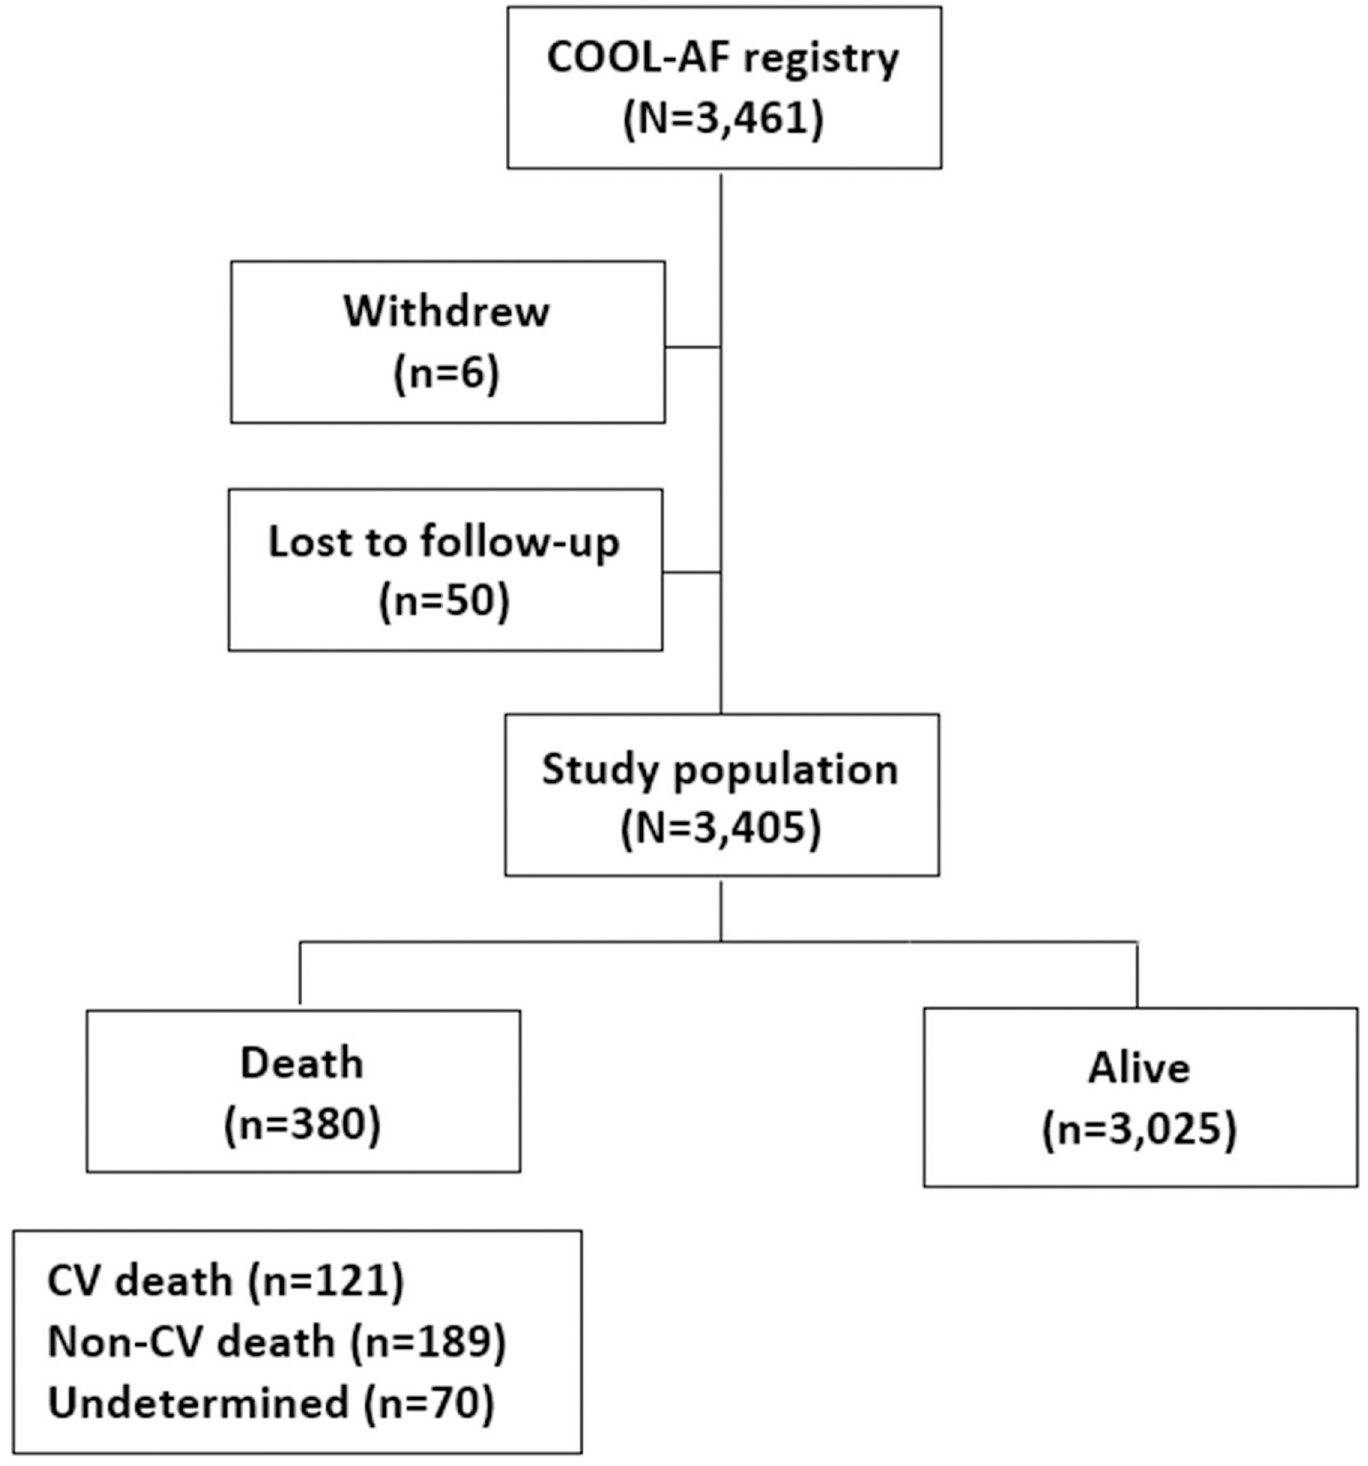
Fig 1. Flow diagram of patient enrollment and the flow of patients in this study. (Abbreviations: COOL-AF, COhort of antithrombotic use and Optimal INR Level in patients with non-valvular Atrial Fibrillation in Thailand; CV, cardiovascular).